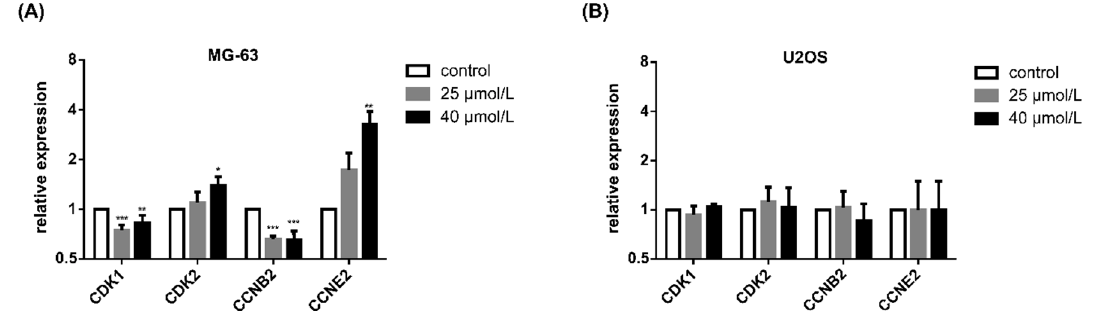
Figure 4. Effects of DiOHF on the gene expression of cell cycle regulators. Relative gene expression relative to control was calculated for ( A ) MG ‐ 63 and ( B ) U2OS cells exposed to DiOHF for 48 h. The data are mean ± SD ( n = 3). Significant differences (asterisks) are shown relative to 0.1% DMSO control; * p < 0.05, ** p < 0.01, *** p < 0.001 (one ‐ way ANOVA).